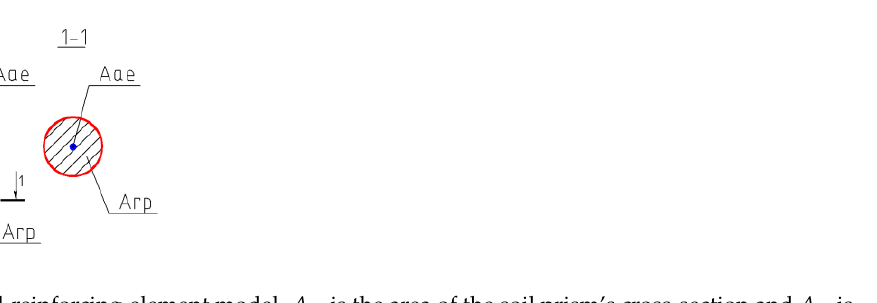
Figure 5. Soil-reinforcing-element model. A rp is the area of the soil prism’s cross-section and A ae is the surface area of a single vertical element.